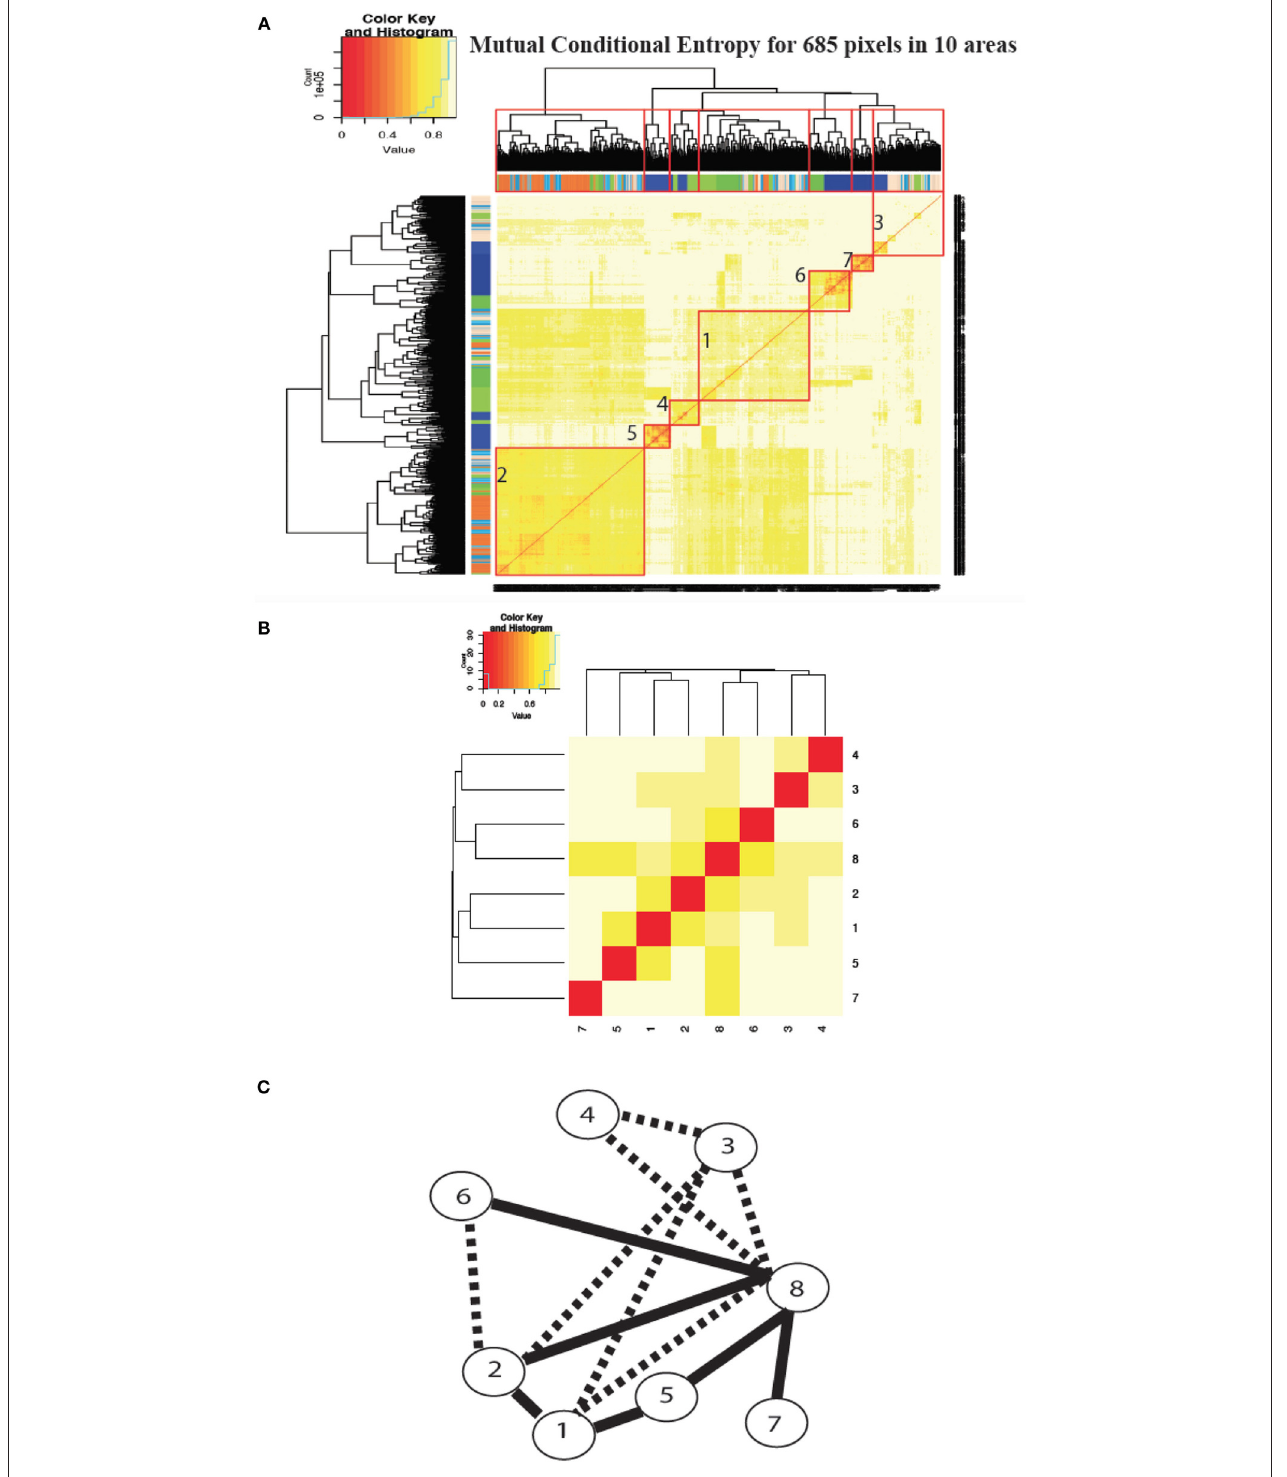
FIGURE 3 | Spatial communities among 685 pixels selected from five brain regions: (A) identification of 7 communities; (B) mutual conditional entropies matrix of 7 collections of community-specific system states; (C) network representation of temporal-connectivity among the 7 communities (the solid linkages have mutual entropies being < 0.7 for indicating high associations, while dotted linkages have mutual entropies more than 0.7 for indicating low associations).